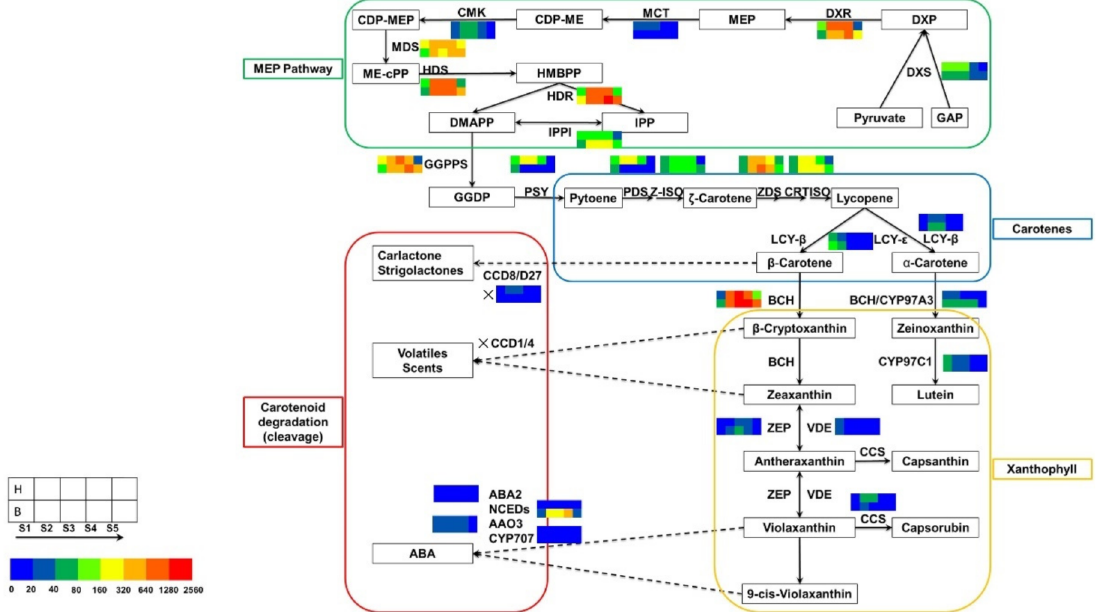
Figure 6. Expression patterns of DEGs related to the carotenoid biosynthesis pathway in tepals during flower development. Enzyme names and expression patterns are indicated at the side of each step. Color boxes from left to right represent unigenes showing lower or higher expression level in bud stage, initial flowering stage, full bloom stage, full expansion stage, and decay stage, respectively. The first row represents the yellow mutant, while the second row represents ‘Jinzhan Yintai’. Different colors represent magnitude of log 2 (expression ratio) for each unigenes, with the FPKM values being grouped in 0–20, 20–40, 40–80, 80–160, 160–320, 320–640,640–1280, 1280–2560,